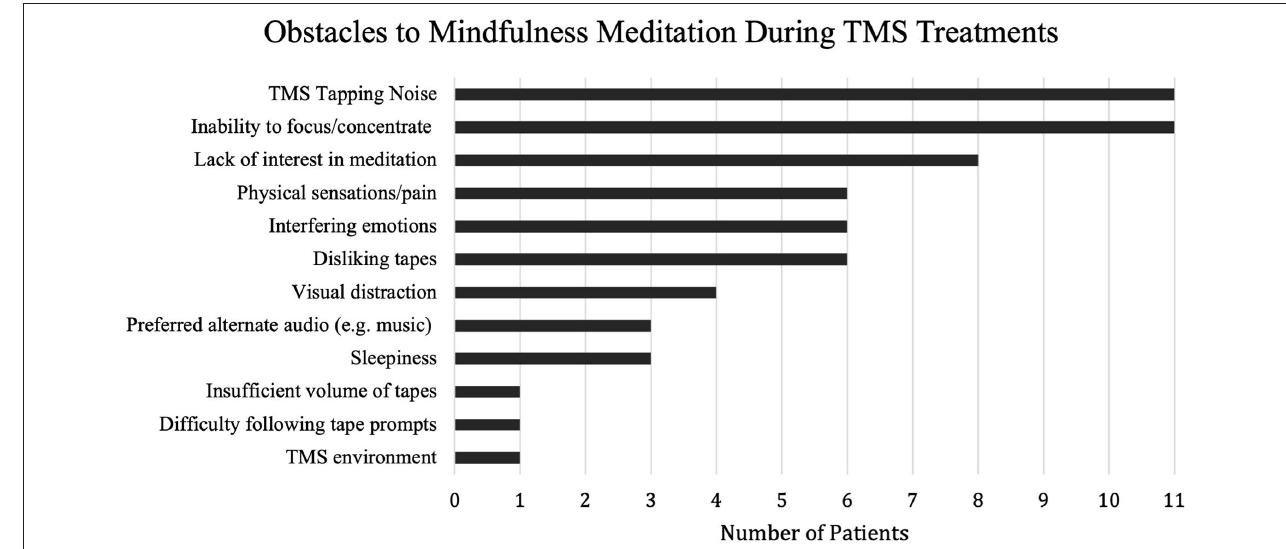
FIGURE 2 | Feasibility Questionnaire Participant Responses. TMS = Transcranial Magnetic Stimulation.